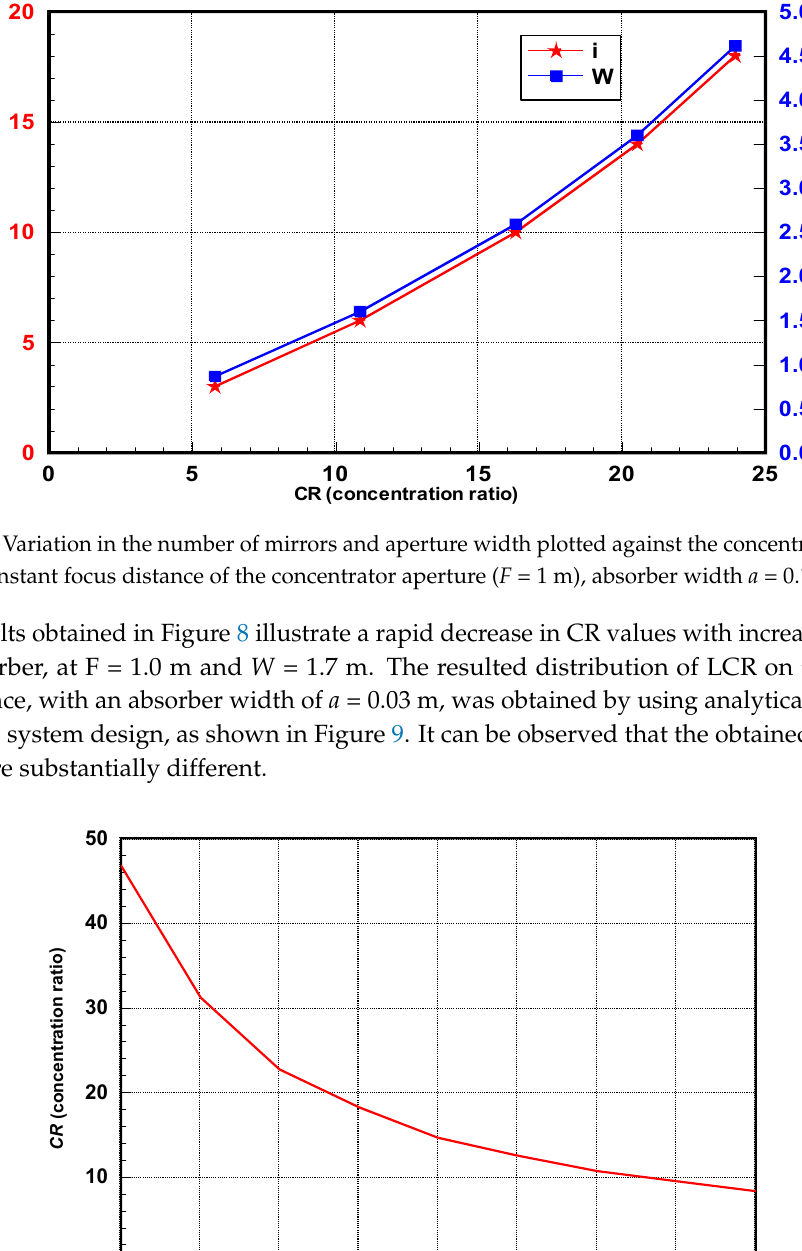
Figure 8. Variations in the CR plotted against the width a of the absorber with focus distance F = 1.0 m, concentrator apparatus width W = 1.7 m.